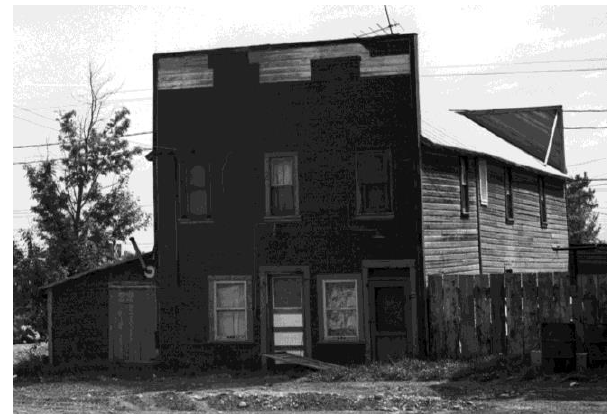
Figure 2: Addition at rear façade with boomtown storefront addressing 25 Street; shed at east side; Insulbrick cladding, regular fenestration pattern, (2) entrances, 1973. Source: HRM